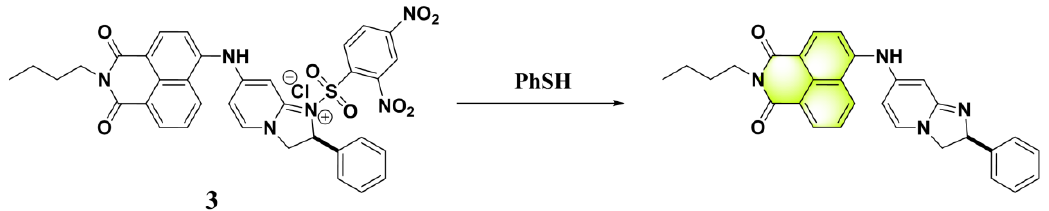
Figure 2. Structure and reaction of probe 3 with PhSH.